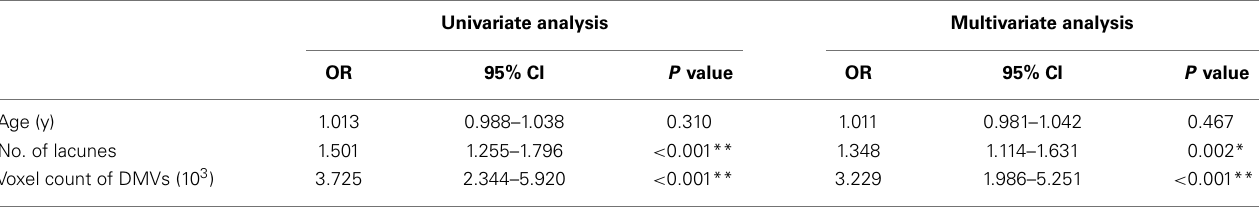
Table 2 | Multivariate logistic-regression analysis of risk factors for large correctedWMH volume ( > 25ml) .